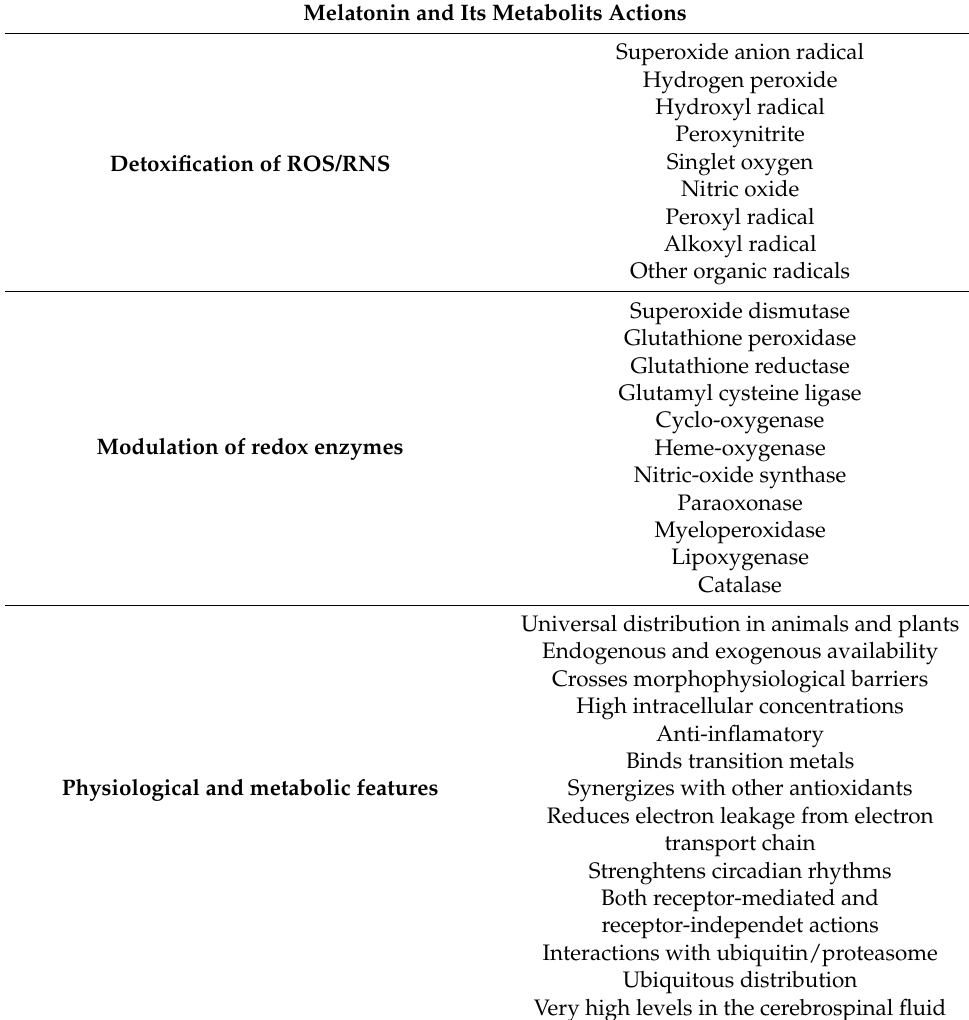
Table 2. The table summarizes the multiple actions of MEL in reducing oxidative stress. First, the reactive oxygen (ROS) and reactive nitrogen species (RNS) that have been shown to be neutralized by MEL and metabolites that are formed during its antioxidant cascade. Enzymes that impact the redox state of the cell are also identified because they either cause the generation of radicals or metabolize them to inactive products. The former is upregulated while the latter are downregulated by MEL and/or its metabolites. Glutamyl cysteine ligase induces the formation of glutathione, an important intracellular antioxidant. Finally, the list of features that aid MEL in terms of its ability to quench free radicals and reduce oxidative damage is included. Adapted from Limson et al.